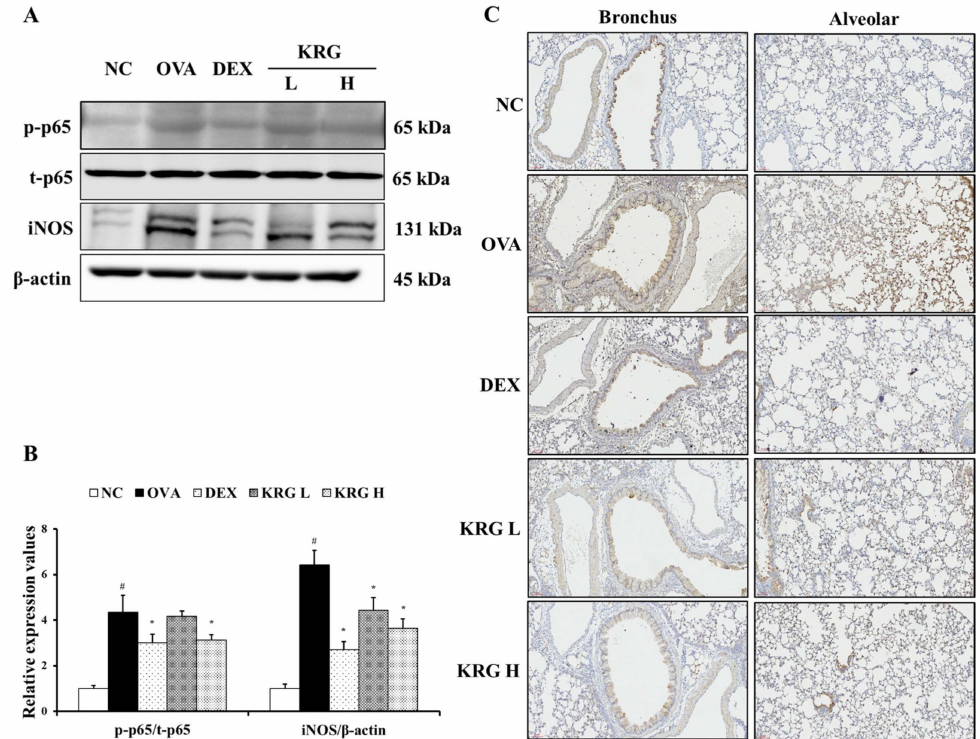
Figure 7. Korean red ginseng (KRG) reduces the levels of phosphorylated nuclear factor kappa-light- chain-enhancer of activated B cells (NF- κ B) and inducible nitric oxide synthase (iNOS) expression in the lung tissue induced by ovalbumin (OVA) treatment. Images of band ( A ) were selected according to each protein’s molecular size and the relative ratios of each protein ( B ) were determined using Chemi-Doc. ( C ) iNOS expression in the bronchus and alveolar regions of lung tissues was revealed by immunohistochemistry (IHC). Normal control (NC) group; mice administered with the vehicle, OVA, group; mice treated with OVA and administered with the vehicle, dexamethasone (DEX), group; mice treated with OVA and administered with dexamethasone (3 mg/kg); KRG low (KRG L) and high (KRG H) groups; mice treated with OVA and administered with KRG (100 and 300 mg/kg, respectively). Values: means ± standard deviation ( n = 6). Significance: # p < 0.05 vs. NC; * p < 0.05 vs.